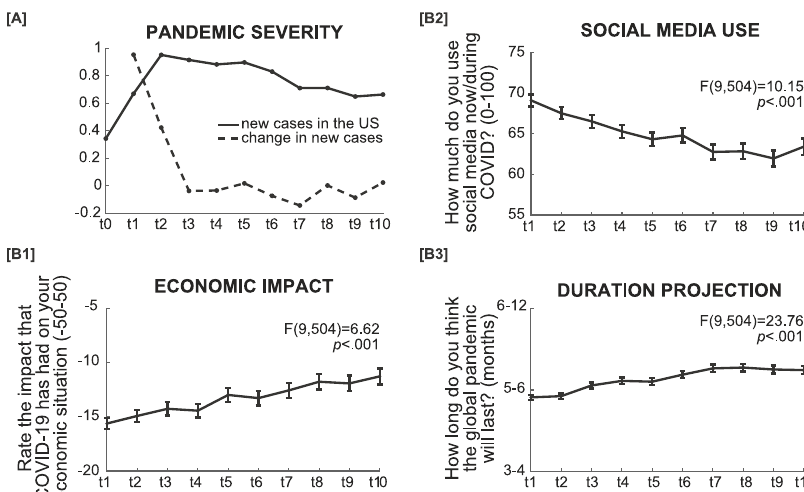
Fig. 2 Dynamic variables in the study. A COVID-19 severity was measured as a 7-day running average of the number of daily new cases (per 10 K), and a weekly change in said average between timepoints. B Self-reported economic impact, social media frequency use, and subjective projection of pandemic ’ s duration during data collection. Statistics were calculated on participants with complete data ( n = 743), but plots re fl ect every valid observation per time-point. The economic impact is overall negative but improves with time [B1]. Individuals reported using social media less frequently with time [B2]. Individuals ’ projected duration for the pandemic increased with time [B3]. Error bars represent standard